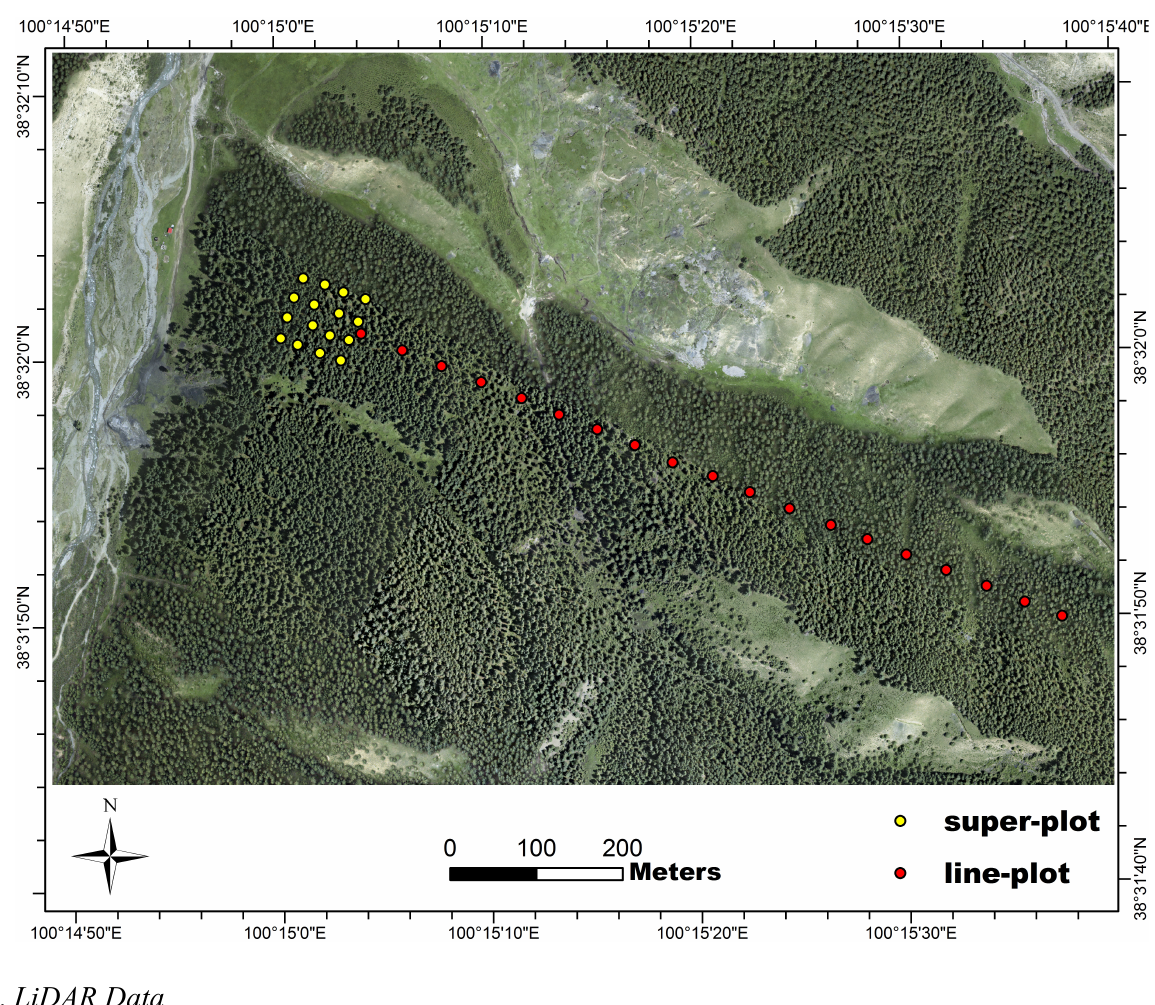
Figure 1. Airborne ortho charged coupled device (CCD) image for the study area and the field